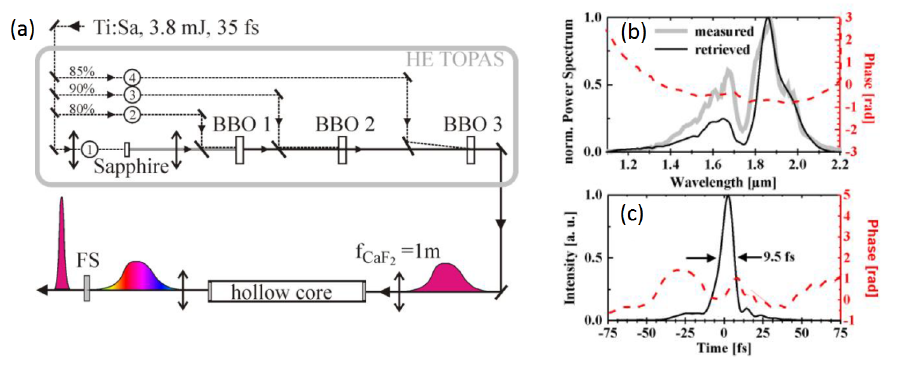
Figure 4. ( a ) Scheme of the OPA setup for the generation of sub-two-cycle CEP-stable near-IR pulses; ( b ) results of the IR pulse temporal characterization: measured (gray) and retrieved spectral intensity (black) and phase (dashed red); ( c ) temporal intensity profile corresponding to a pulse duration of 9.5 fs. FS, Fused Silica. Adapted with permission from [33], Copyright OSA Publishing,